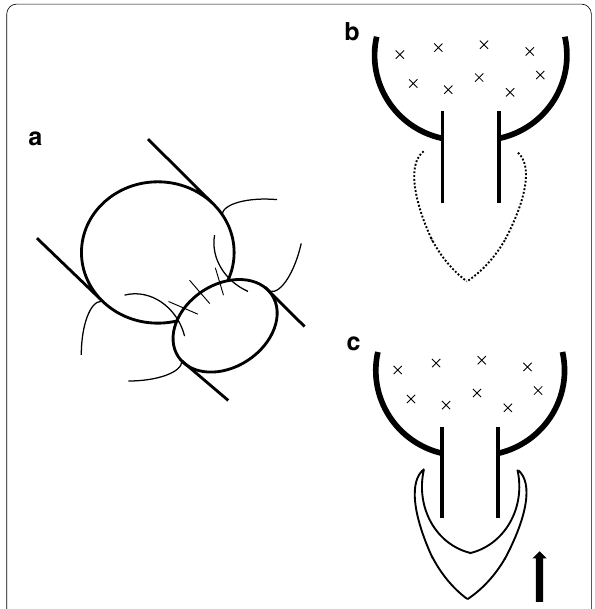
Fig. 1 Intraoperative scheme. a Telescope anastomoses were performed. b Pericardial incision line (dotted line) of the pericardiotomy at the lower edge of the superior pulmonary vein. c The middle lobe was passively moved approximately 1.5 cm toward the cranial side (black arrow) after the